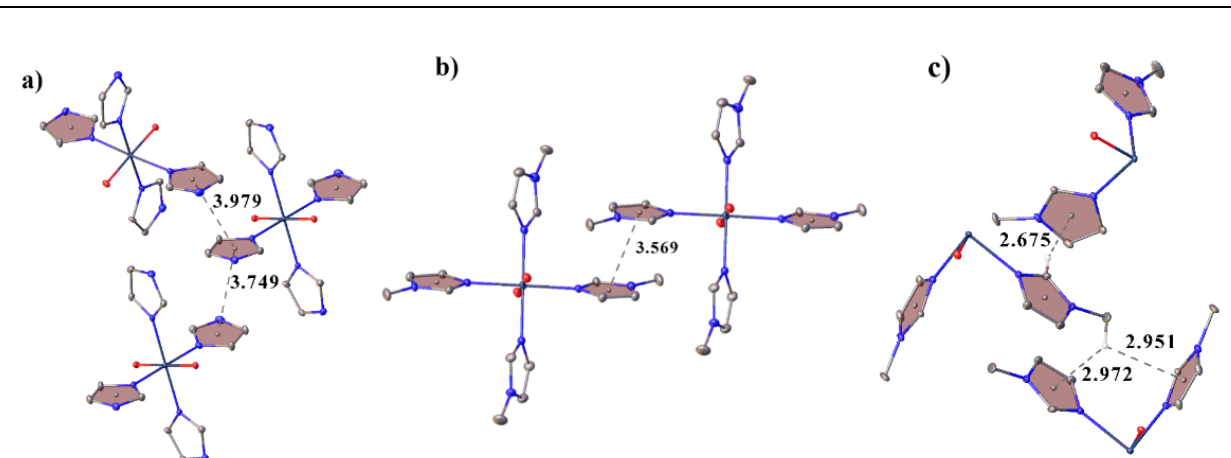
Figure 3. View showing π –stacking interactions in the structures II ( a ), III ( b ) and CH- π interactions in IV ( c ). Only the hydrogen atoms involved in the CH- π interactions are shown.